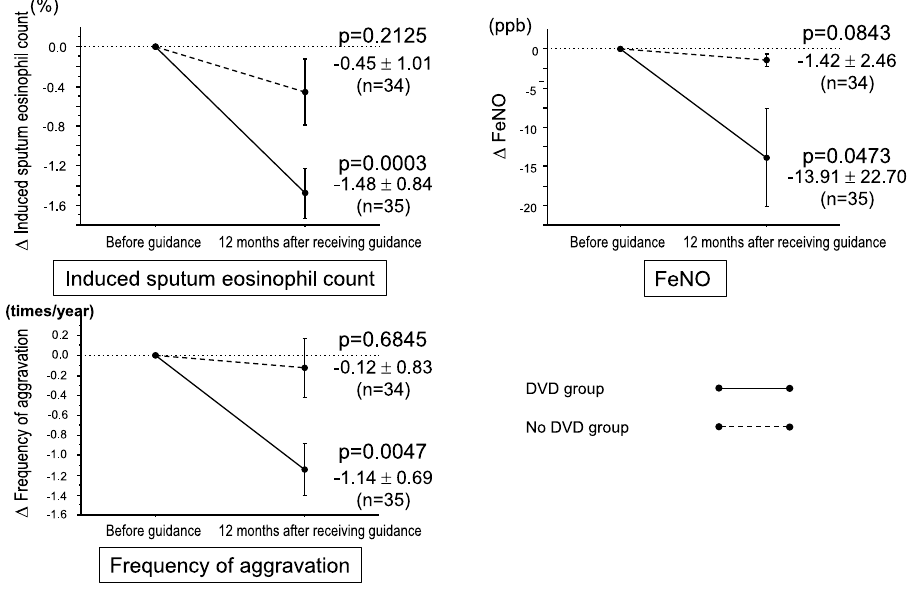
Figure 3 Changes in respiratory function parameters 12 months after undergoing inhalation guidance using